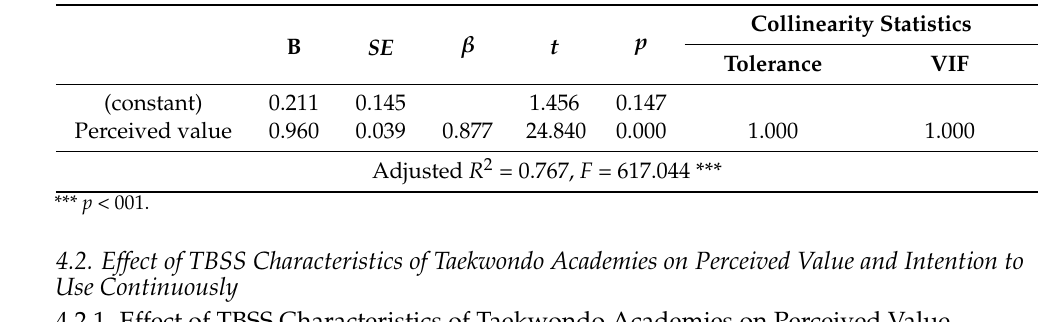
Table 7. Effect of perceived value on the intention to use